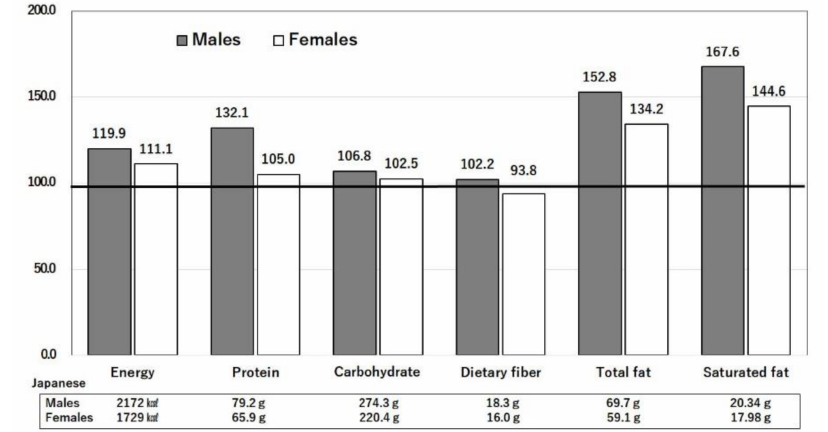
Figure 4. Ratios of macronutrient intakes in the U.S. compared with Japan. Daily intakes of the three major nutrients by Japanese men and women were set to 100% and compared with the intakes of American men and women. The actual daily values of Japanese intakes are shown below each bar. The